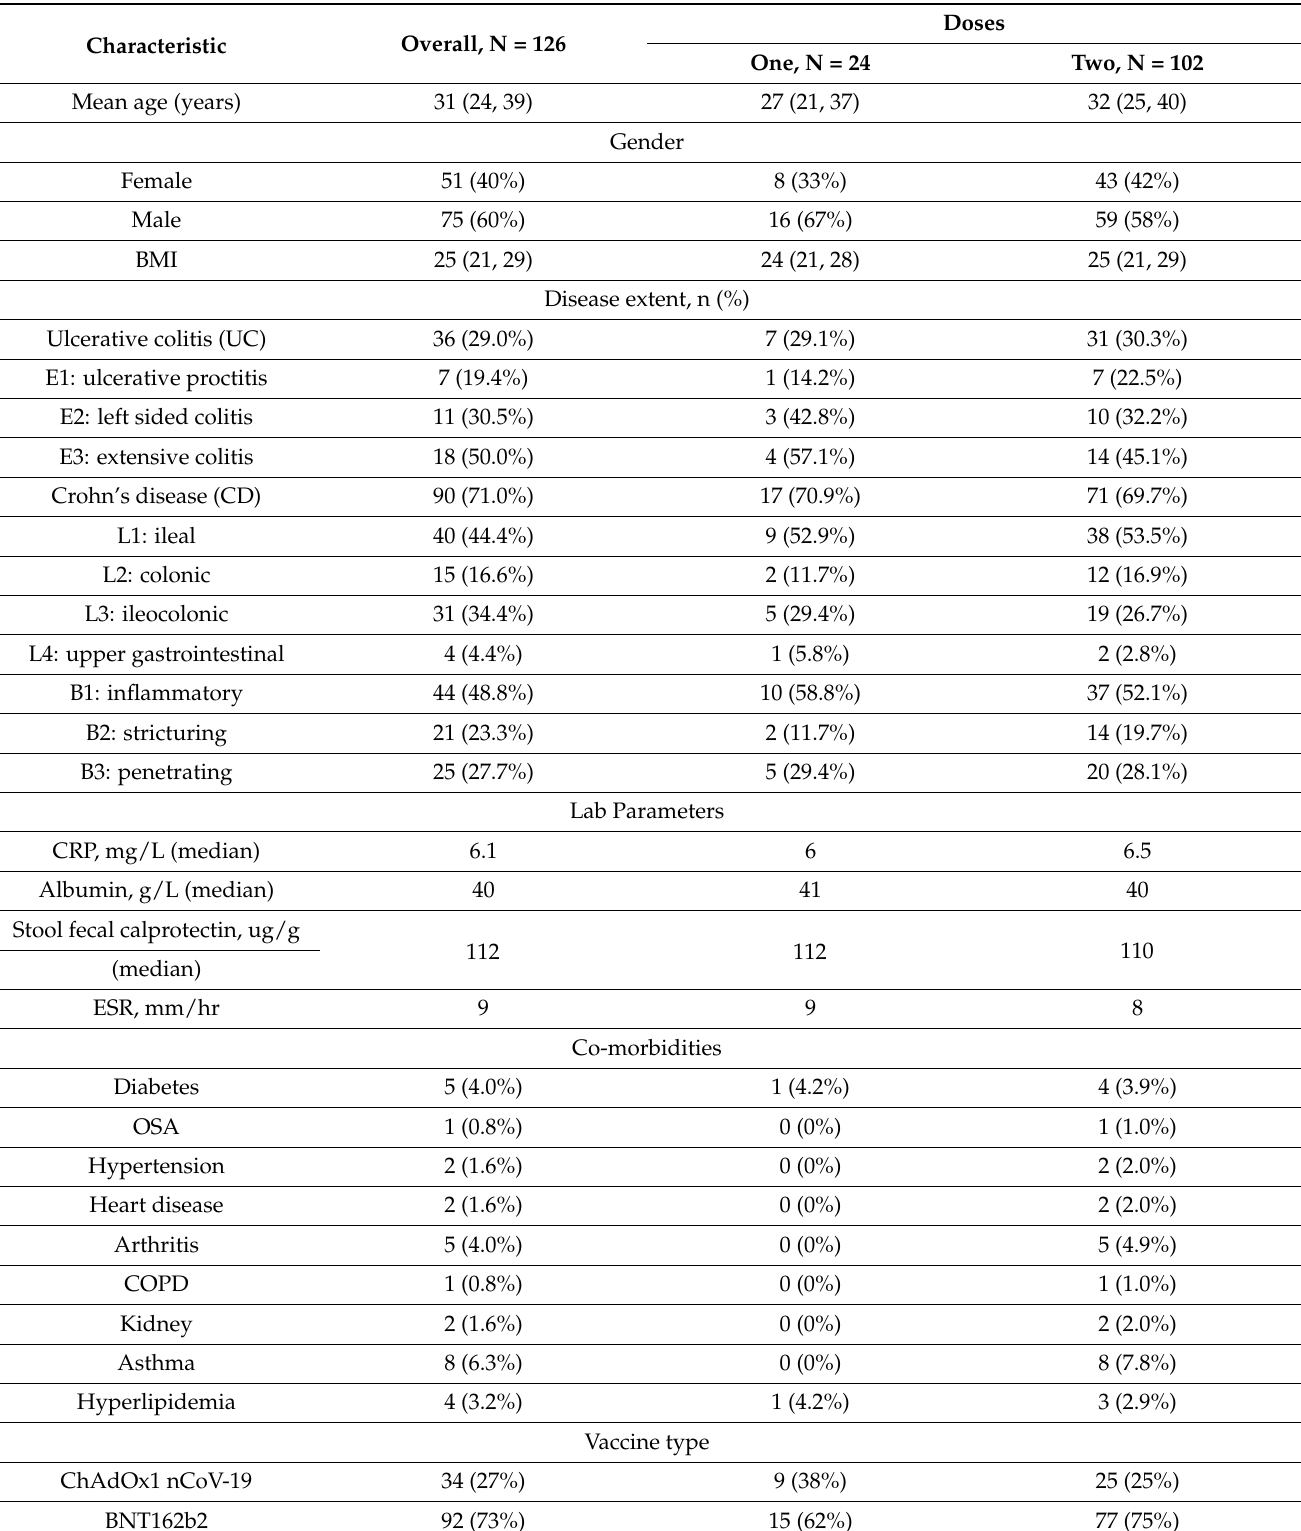
Table 1. Demographic characteristics of all included